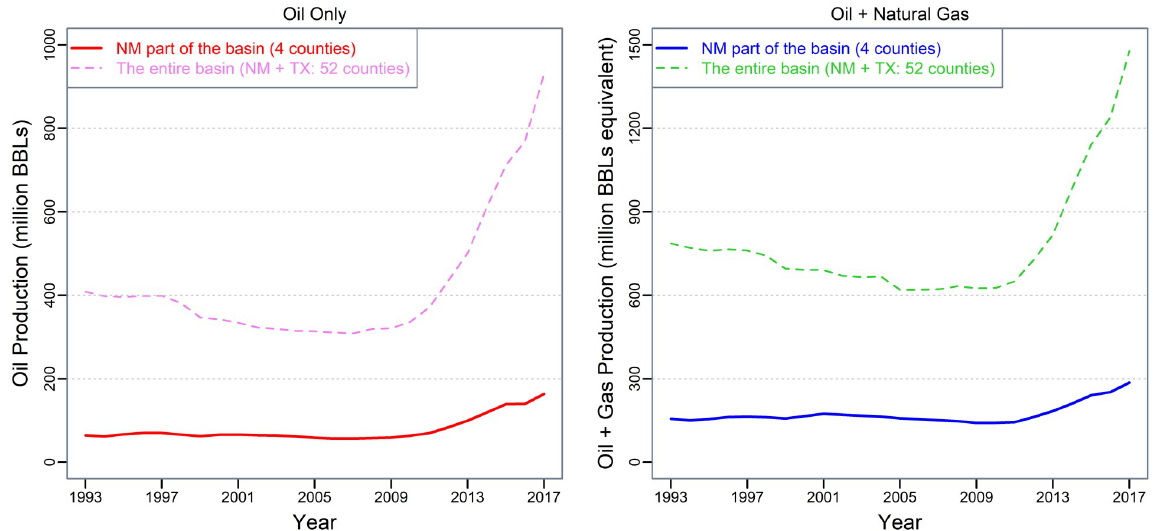
Fig 1. Oil and natural gas production in the Permian Basin counties (TX + NM). Note: The author produced the figure in R. Data source: The Petroleum Recovery Research Center at New Mexico Tech and the Railroad Commission of Texas. Natural gas production is converted to oil equivalent based on one MCF natural gas � 0.18 BBL oil (recommended by the US Energy Information